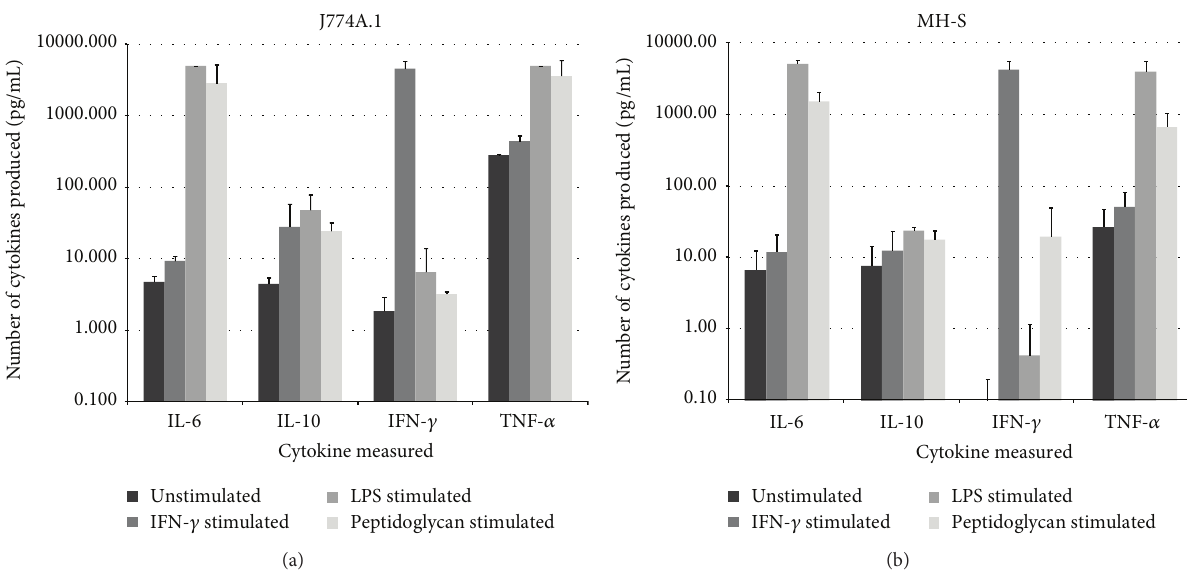
Figure 1: ((a) and (b)) Cytokine production from stimulated J774A.1 and MH-S cells. Cytokine concentrations were measured 24 hours after stimulation with LPS (5 𝜇 g/mL) or IFN- 𝛾 (1 𝜇 g/mL). Values are the means and SEM from at least three independent experiments. There were significant differences in TNF- 𝛼 production between the cell lines for unstimulated, LPS stimulated and peptidoglycan stimulated cells.